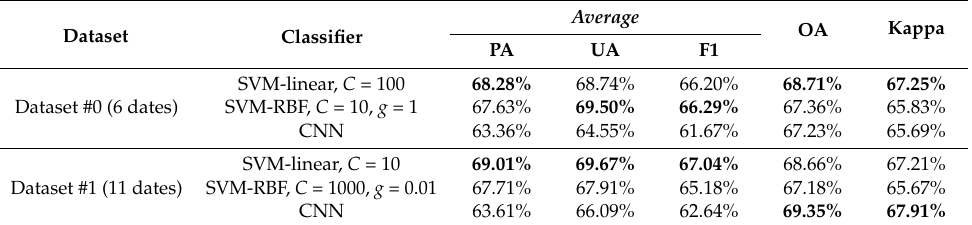
Table 3. Quantitative results after the application of the SVM and CNN classifiers.